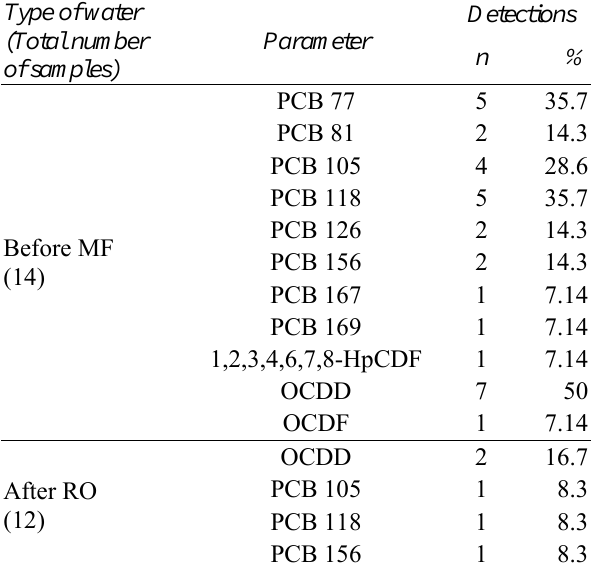
Table 6: Detected dioxins and dioxin-like compounds in wastewater and product water Type of